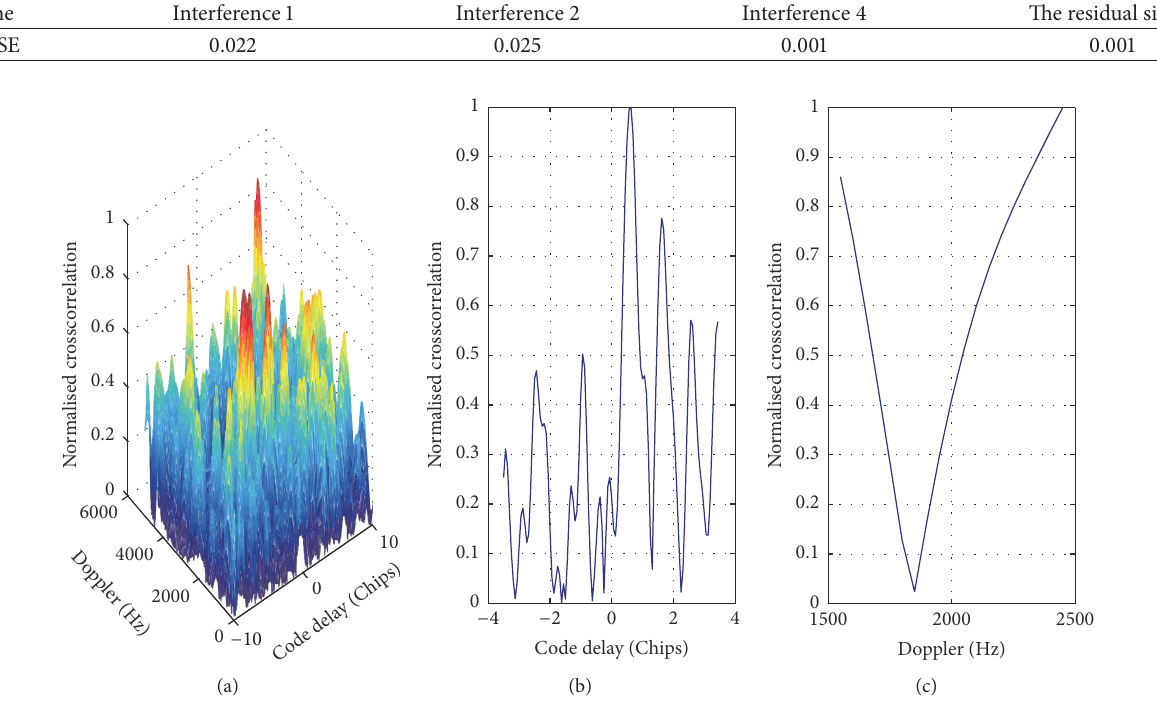
Table 4: Normalized mean square error (NMSE) of estimated signals.